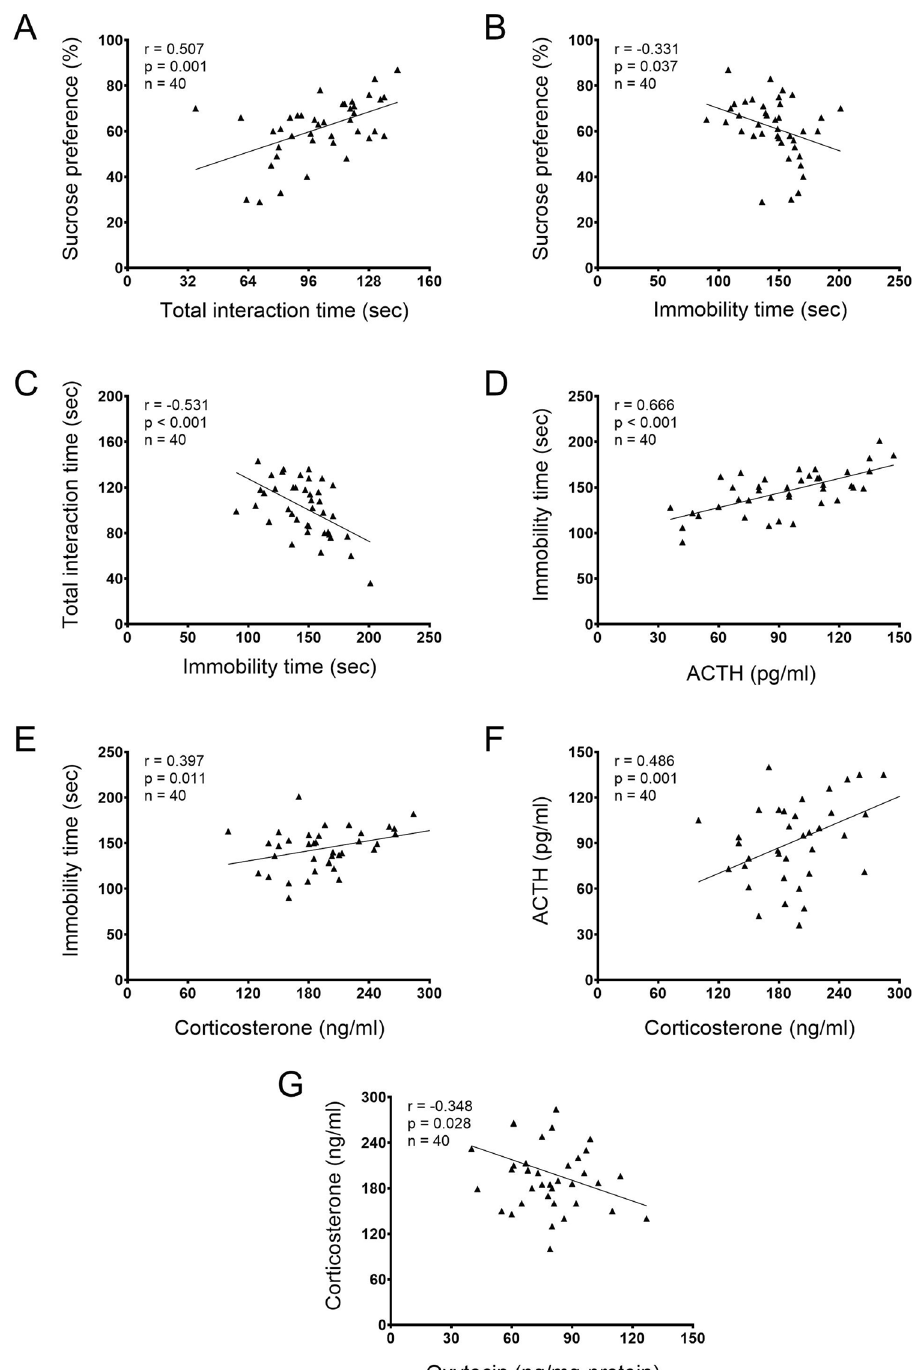
Figure 8. Pearson correlations between depression tests and HPA axis function or oxytocin. Correlation coefficient: r; the number of animals: n; p-value: